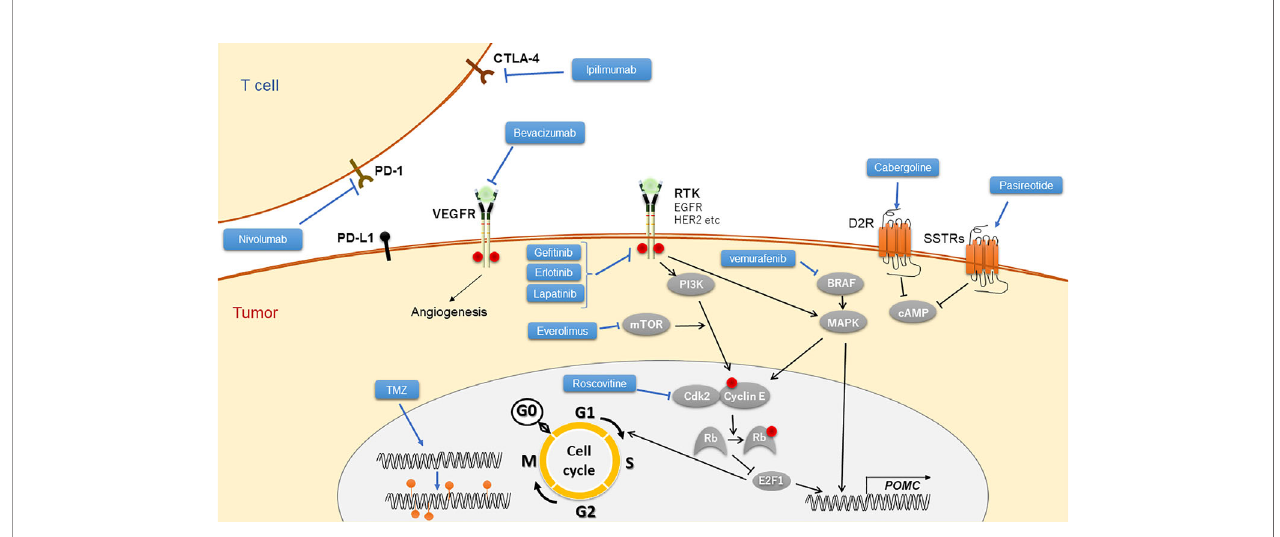
FIGURE 1 | Targeted drugs to Cushing ’ s disease and their mechanistic scheme. TMZ, temozolomide; RTK, receptor of tyrosine